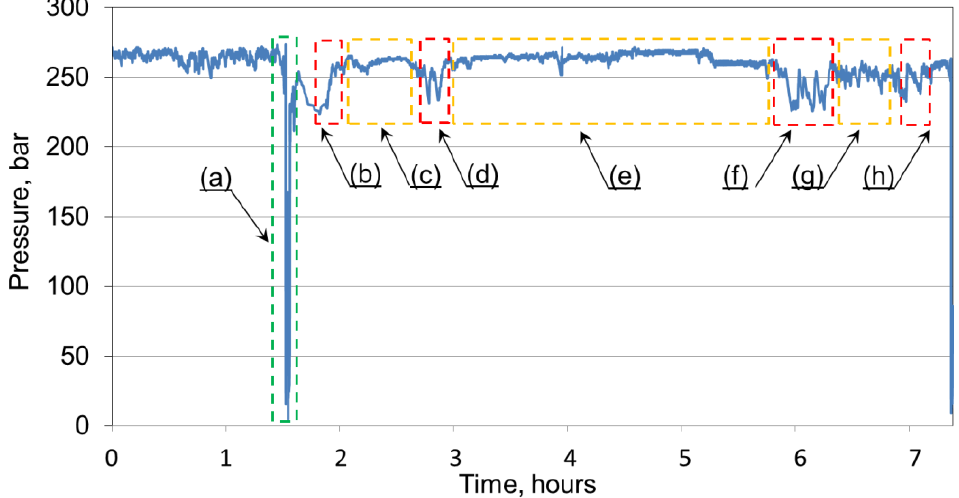
Figure 7. Analysis of the charging function in real conditions.